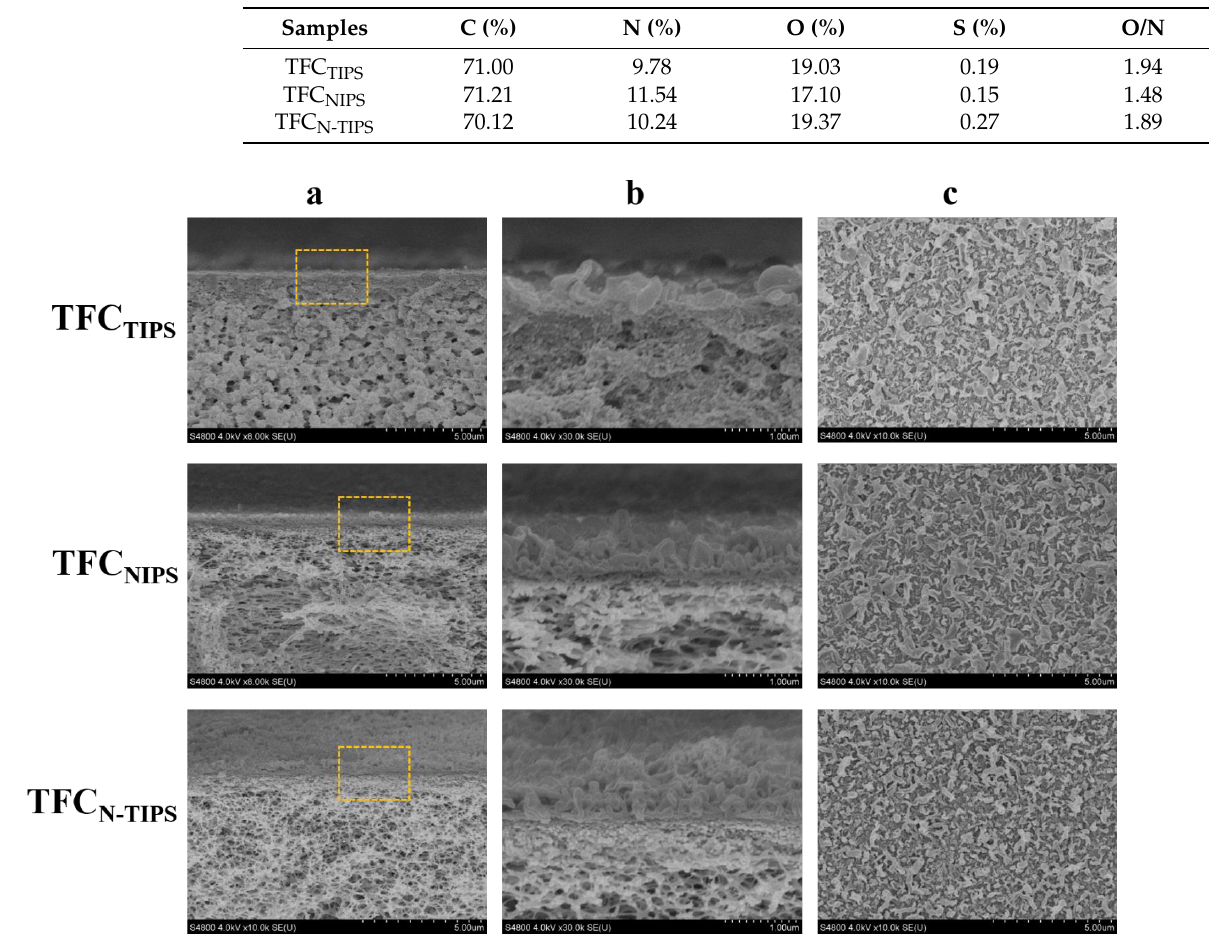
Figure 5. SEM images illustrating the cross-section ( a , b ) and top surface ( c ) of TFC-FO membranes. The images of line b show the magnified morphology of the regions indicated by the rectangles in the images of line a.